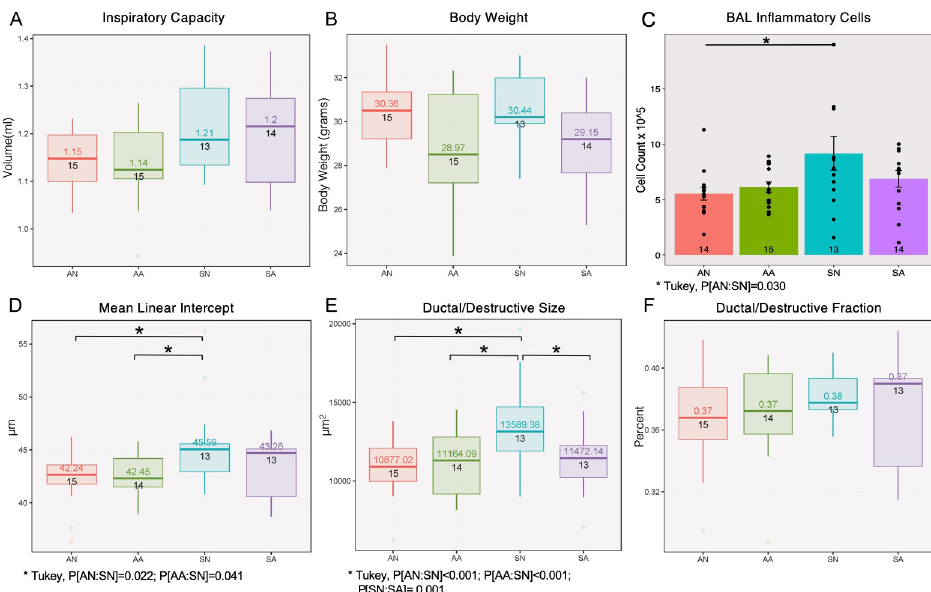
Fig 3. Effects of AAT ASO knockdown in smoke-induced COPD model. Smoke exposure contributes to changes in inspiratory capacity (A, volume, P[exposure] = 0.017), inflammation (C, bronchoalveolar lavage cell counts, P [exposure] = 0.020) and emphysema (D-E, mean linear intercept, P[exposure] = 0.011; ductal/destructive size, P [exposure] < 0.001). Antisense treatment contributes to changes in body weight (B, P[treatment] = 0.015) and ductal/ destructive size (E, P[treatment] =